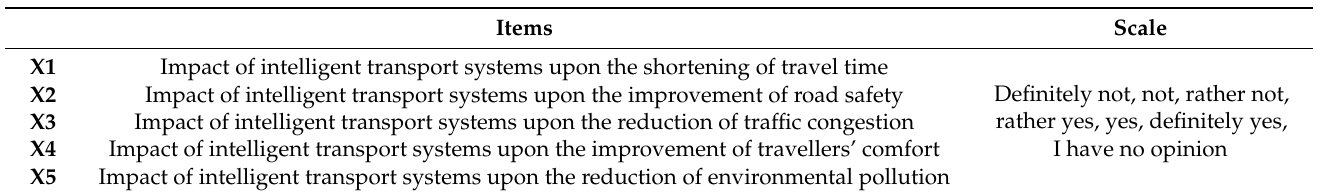
Table 4. Measurement scale for the perception of benefits of intelligent transport systems. Items